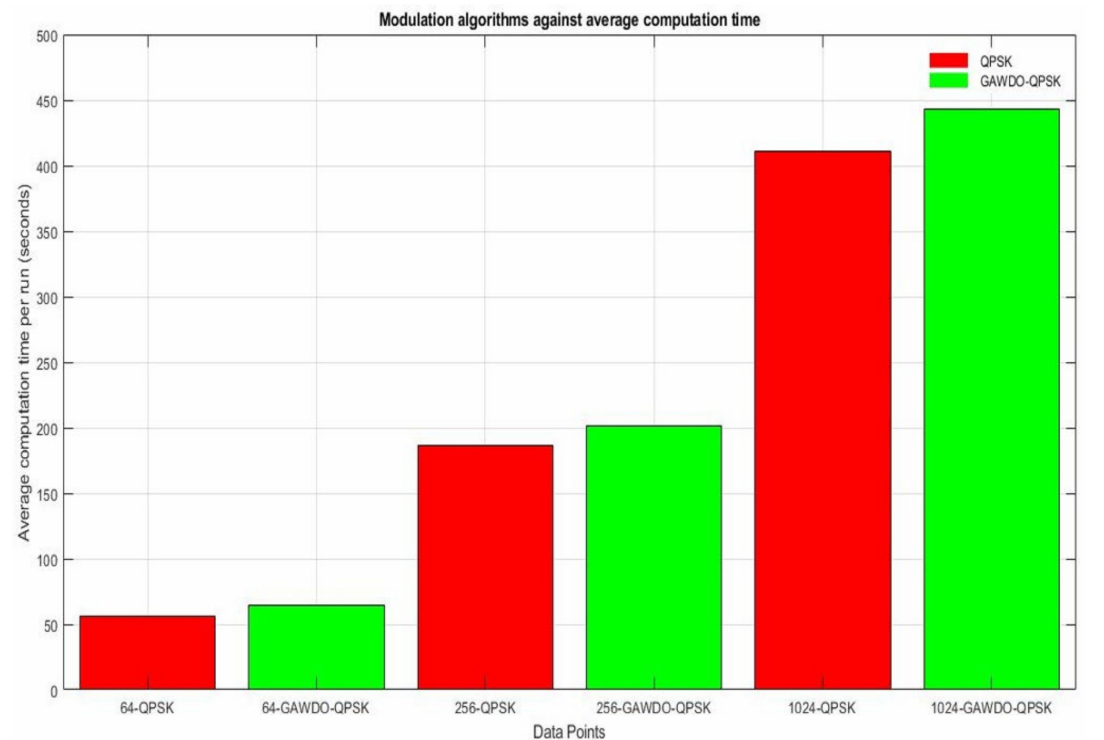
Figure 16. Modulation algorithms plotted against their average computational